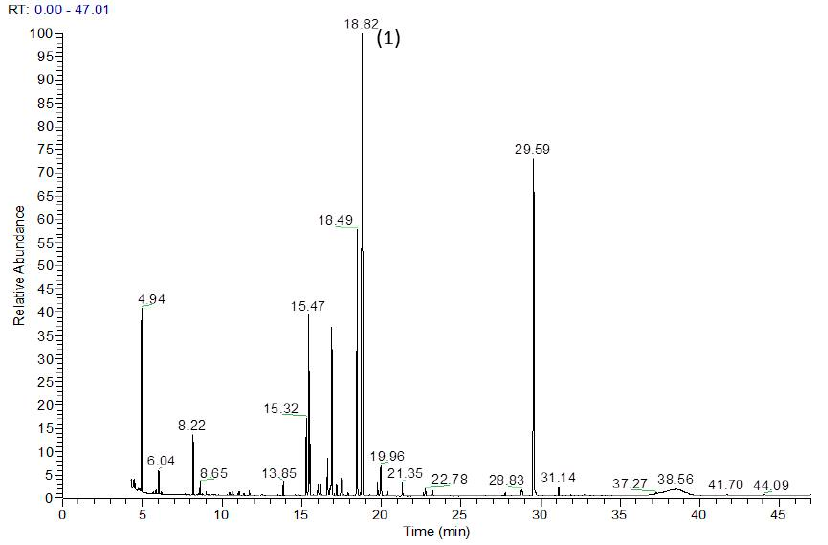
Figure 1. Chromatogram representative of methanolic extracted from A. tinctoria aerial parts. Peak 1: ononitol.